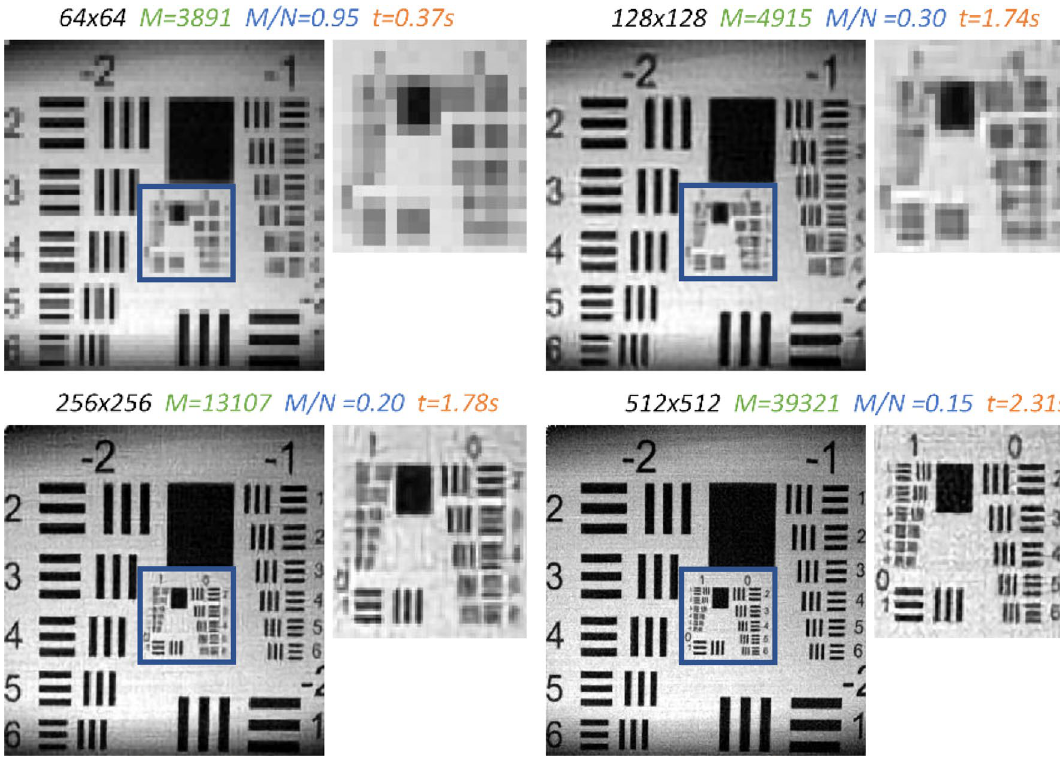
Figure 3. Reconstructions of progressive CS of a USFA MTF target taken by an SPC system in this figure. The number of samples taken at each stage is denoted by M in green, the compression is denoted by M/N in blue, and the reconstruction time is denoted by t in orange.